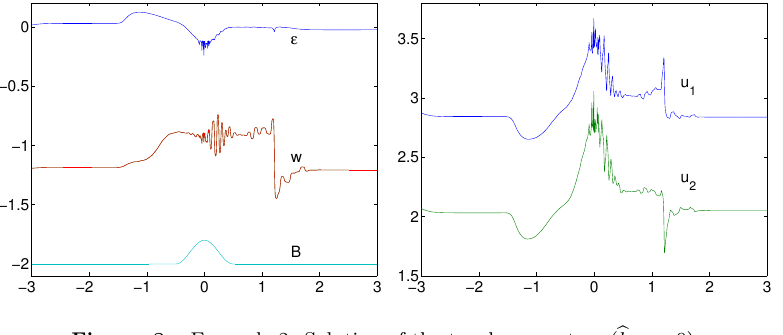
Figure 8. Example 2: Solution of the two-layer system ( (cid:98) h m = 0).